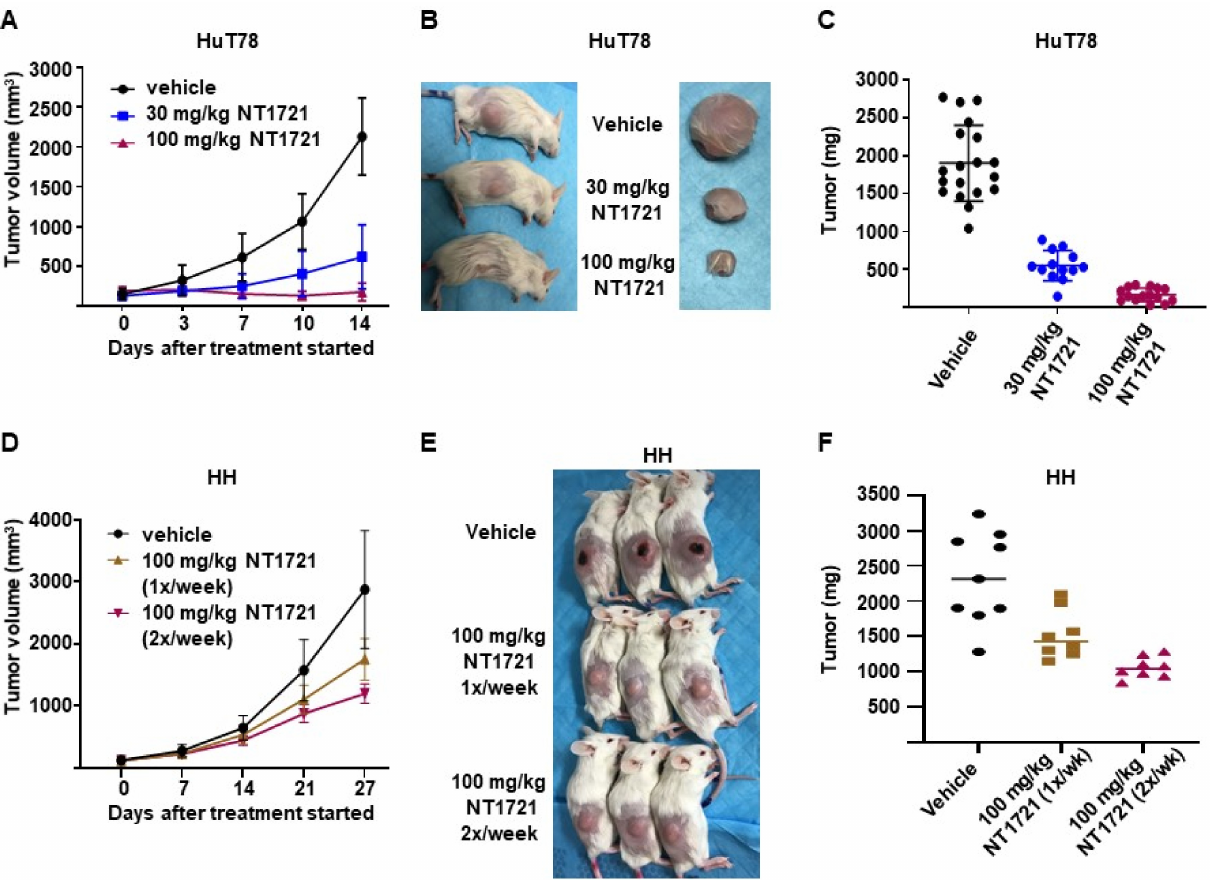
Figure 5. In vivo efficacy of a DMSO-free formulation of NT1721. ( A – C ) NSG mice bearing HuT78 tumors were treated with 30 mg/kg (five times per week), 100 mg/kg NT1721 (twice per week) or the vehicle control (Ora-Blend containing 10% saline). ( A ) Tumor volume. ( B ) Representative mice and tumors from the treatment and control groups. ( C ) Tumor weight in treated and control mice. The differences between control and treatment groups as well as between the treatment groups were statistically significant ( p < 0.0001). ( D – F ) NSG mice bearing HH tumors were treated with 100 mg/kg NT1721 once a week, 100 mg/kg NT1721 twice per week or the vehicle control (Ora-Blend containing 10% saline). ( D ) Tumor volume. ( E ) Representative mice from the treatment and control groups. ( F ) Tumor weight in treated and control mice. The differences between control and treatment groups were statistically significant (control compared to 100 mg/kg 1 × /week: p = 0.021 and control compared to 100 mg/kg 2 × /week: p =